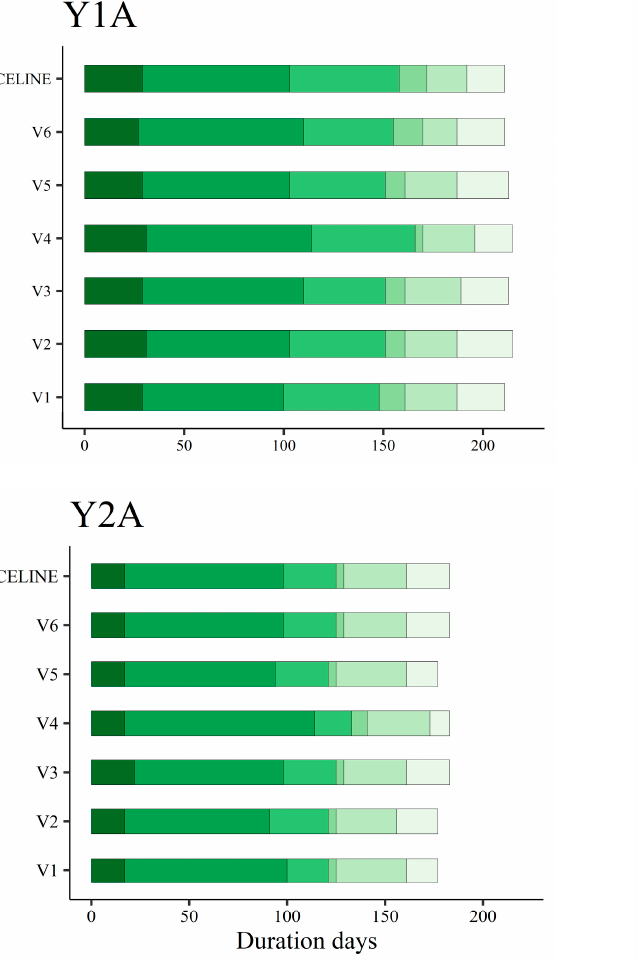
Figure 2. Duration in days of the main phenological growth stages of the seven camelina genotypes sown in autumn 2017 (Y1A) and 2018 (Y2A) and in spring 2018 (Y1S) and 2019 (Y2S).